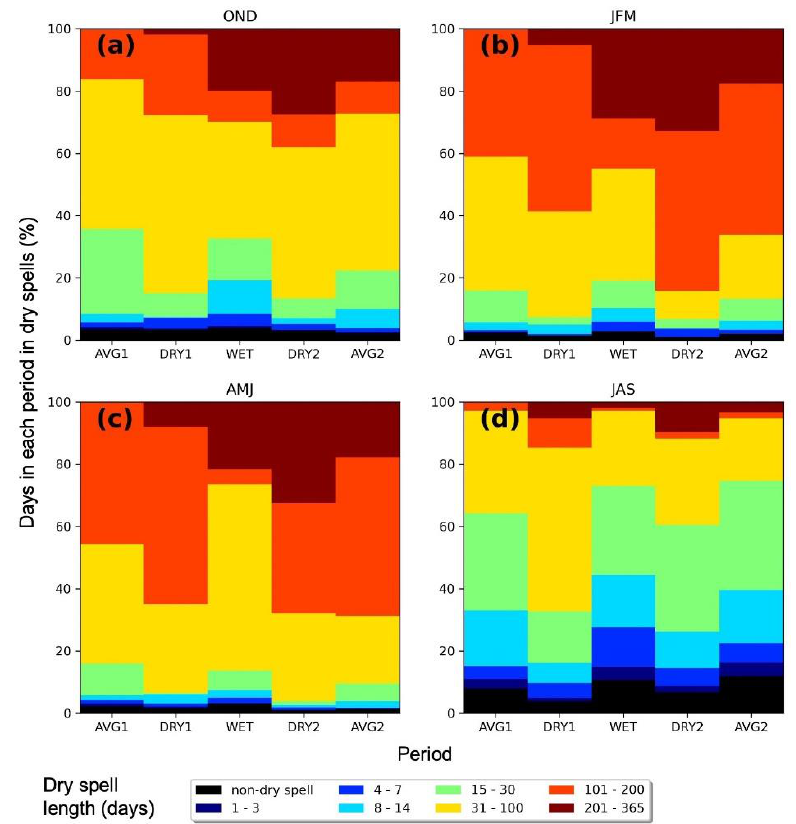
Figure 8. Percentage of days in each period in dry spells (consecutive days with less than 0.5 cm/day) of varying durations (days) as an average of 16 locations for each season. ( a ) OND, ( b ) JFM, ( c ) AMJ, and ( d ) JAS. Black bars represent the percentage of days not in a “dry spell” of at least one day.